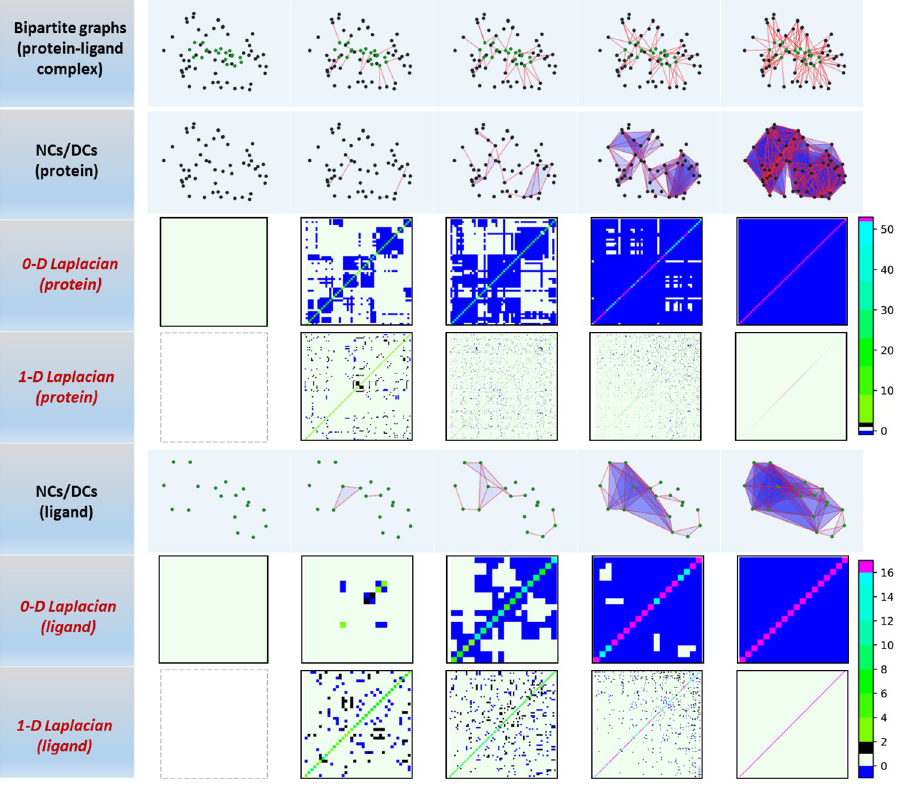
Fig 2. Persistent combinatorial Laplacian matrixes for Dowker complex from C-C pair of PDBID 2POG. As in the picture, based on the filtration process of bipartite graphes, a filtration of Dowker complexes can be generated and further divided into two disjoint filtration processes in protein and ligand. Then for each filtration process, two sequence of laplacian matrixes in dimension 0 and 1 are depicted. The cutoff extracting the binding core region is 5 Å , filtration values are 3.5 Å , 4 Å , 4.2 Å , 4.5 Å and 5 Å . For 0-D laplacian matrixes, with the increase of filtration value, the matrix size is always same, off-diagonal entries decrease from 0 to -1 until all become -1 and diagonal entries increase until all up to the number of 0-simplexes minus 1. For 1-D laplacian matrixes, the matrix size increase consistently until up to a constant, and off-diagonal entries have nonzero values 1 and -1 due to their oriention and the number of off-diagonal nonzero entries increase at early stage and then decrease until all go to zero, and diagonal entries increase until all up to the number of